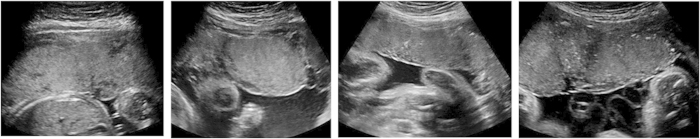
Image samples of 4 stages (from left to right, stage 0 to stage 3 image).